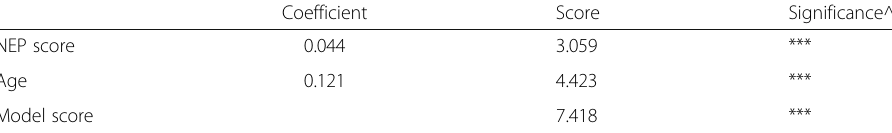
Table 1 Exact logistic regression coefficients, scores, and statistical significance Coefficient Score Significance^ NEP